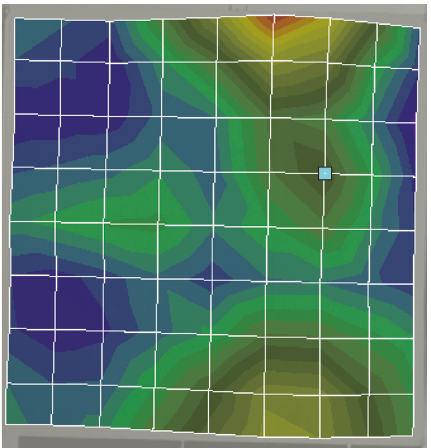
Figure 11: The energy density distribution of a plate without